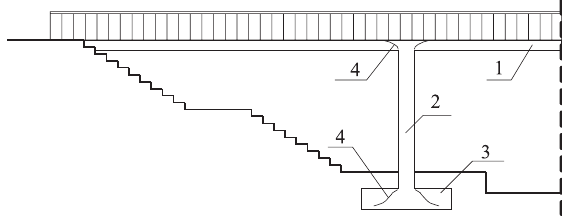
Fig. 1. Diagram of a bridge with superstructure and foundation RC slabs: 1 – superstructure deck slab; 2 – support (column); 3 – supporting foundation – slab; 4 – punching sections